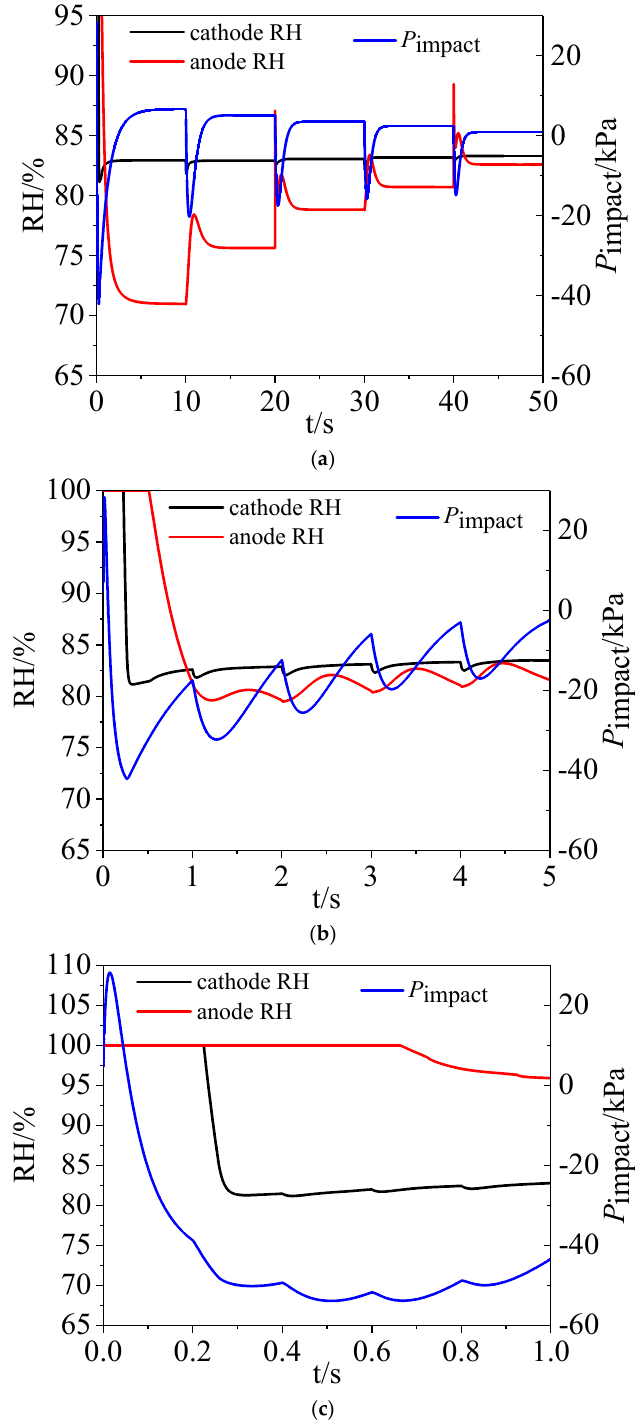
Figure 11. RH and pressure impact on the MEA at different time intervals: ( a ) at interval of 10 s, ( b ) at interval of 1 s, ( c ) at interval of 0.2 s.